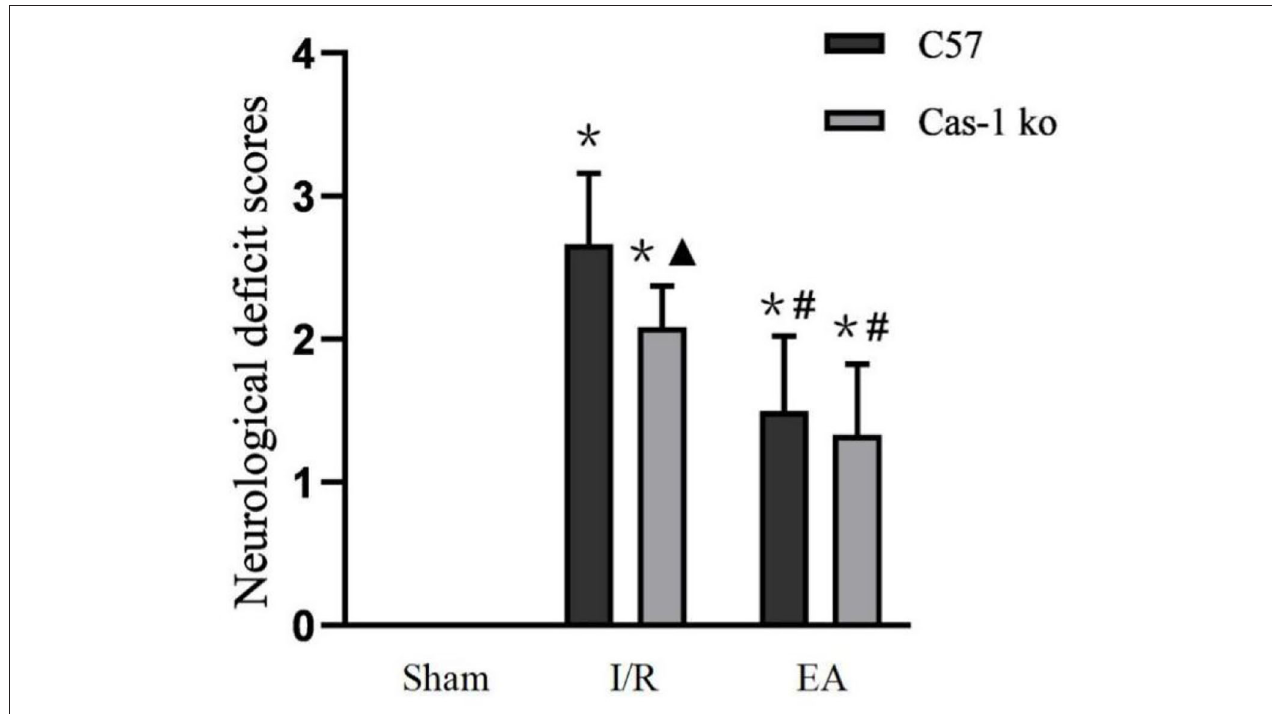
FIGURE 1 | Neurological deficit scores. Comparison within the same genotype: * p < 0.05 vs. Sham group; # p < 0.05 vs. I/R group. Comparison within the I/R group: N p < 0.05 vs. C57 mice. Data are representative of 12 independent experiments (mean ± SD are representative of values from 12 independent